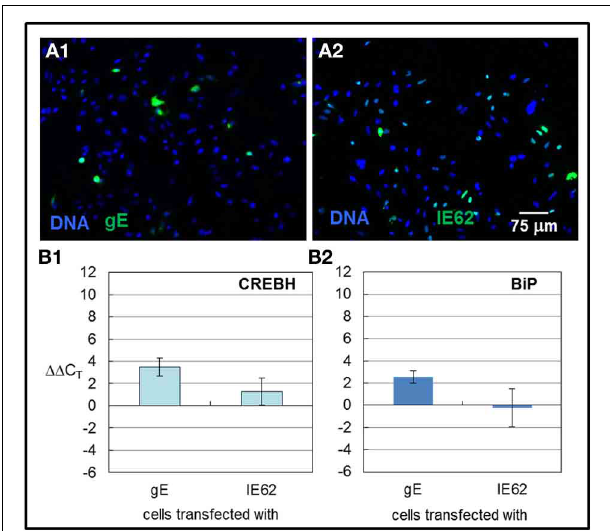
FIGURE 8 | CREBH and BiP transcription were upregulated in cells transfected with VZV gE but not VZV IE62. HeLa cells were grown in six well culture plates with or without glass coverslips and subsequently transfected with plasmids encoding the VZV gE glycoprotein or a non-glycosylated VZV IE62 protein, using either Lipofectamine 2000 or ExtremeGene HP transfection reagents. 6h after the transfection reagent and plasmid were applied to the cells, the medium was replaced with fresh medium. Some monolayers were processed for microscopy while others were harvested for RNA extraction. The extracted RNA was converted to cDNA and RT-PCR was performed using primers against CREBH and BiP . (A1,A2) Representative images of cells transfected with VZV gE (A1) or VZV IE62 (A2) . ( B1,B2) RT-PCR values were normalized to GAPDH and then differences to values measured for cells that were only treated with transfection reagent alone were